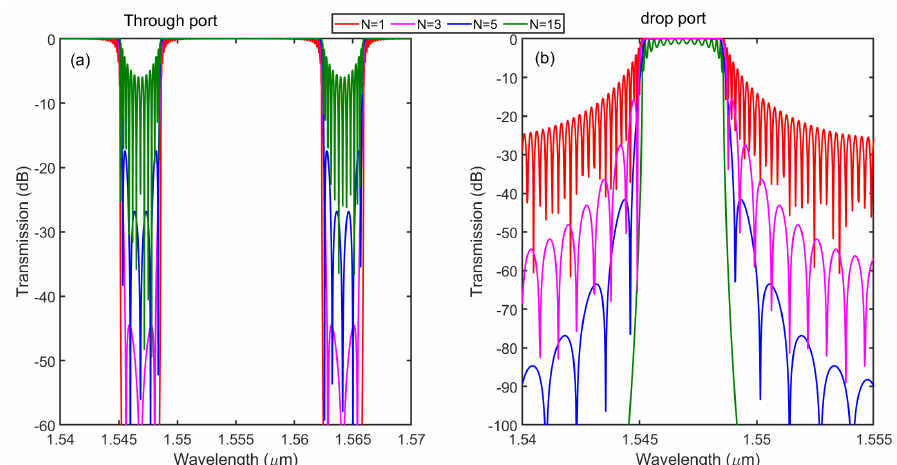
Figure 2. Transmission characteristics of the fixed total number of rings (60 rings): ( a ) through port and ( b ) drop port. The number of rows should be odd. In order to ensure that the number of columns is an integer, we selected the number of rows N as 1, 3, 5, and